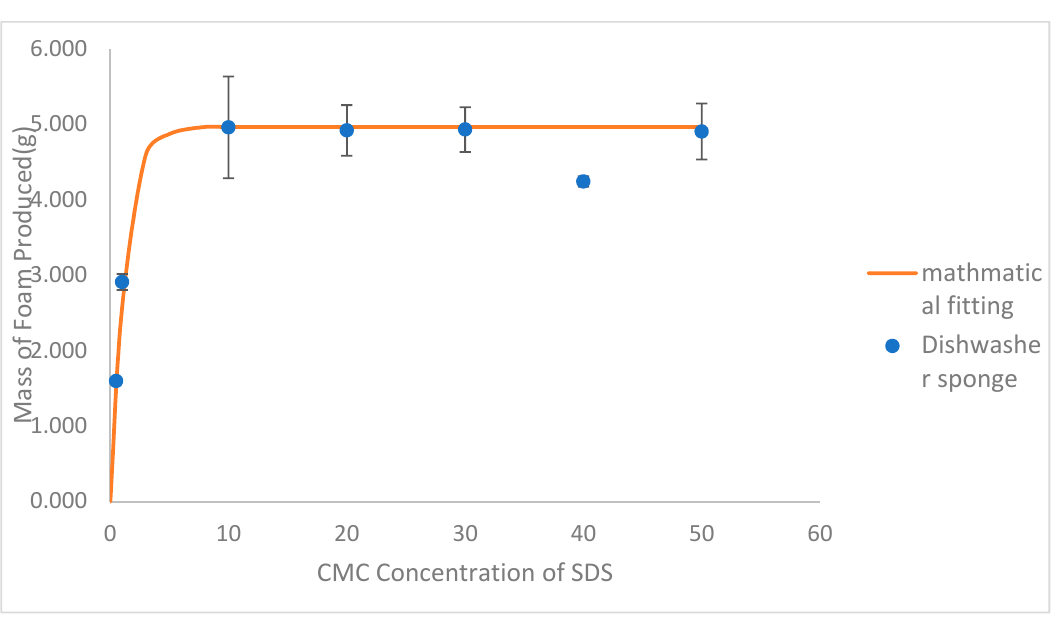
Table 7. Calculated liquid volume fraction for the foam generated for each of the concentrations of SDS solution.